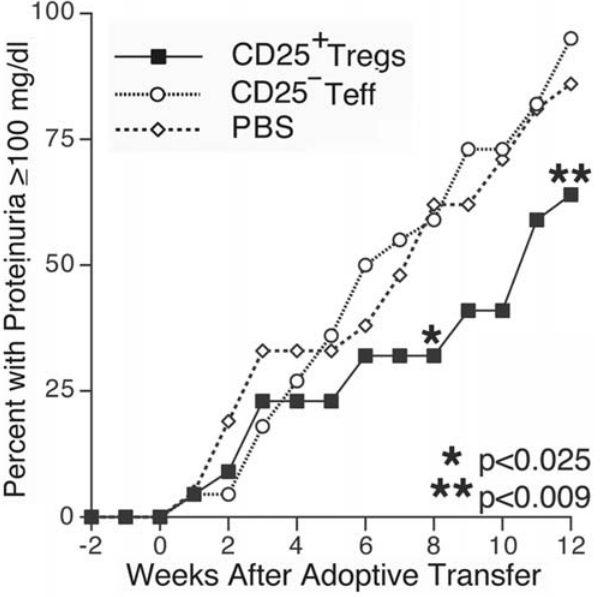
Figure 8. Inhibition of proteinuria in T reg treated mice. Mice receiving adoptively transferred T regs had significantly reduced progres- sion to proteinuria $ 100 mg/dl over the 12 weeks following transfer as compared to either PBS or CD4 + CD25 2 T cell control groups (p # 0.025 starting week 8, n=22 for T reg and T eff groups, n=21 for PBS group).